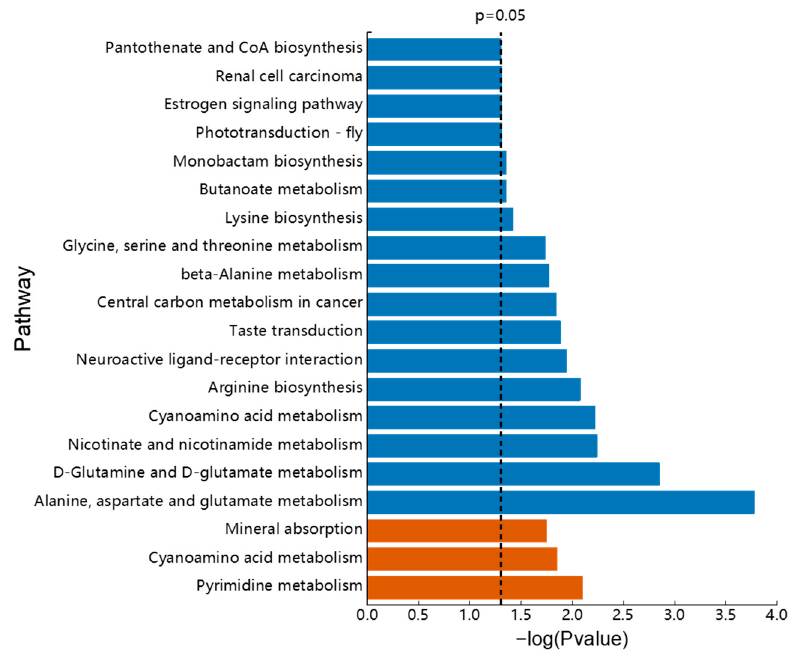
Figure 6. Enrichment analysis of differential metabolic pathways. K1M is shown in orange and K2M is shown in blue. The vertical line mean p = 0.05.